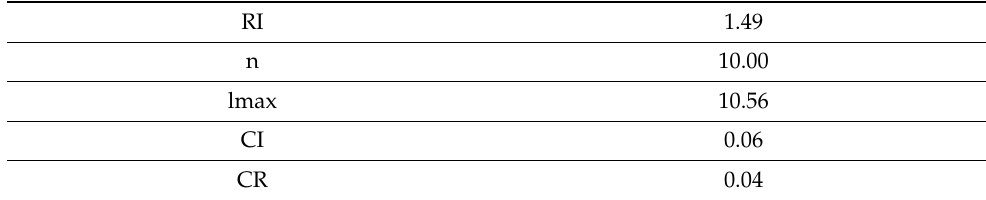
Table 5. Variables used for consistency ratio of susceptibility analysis.